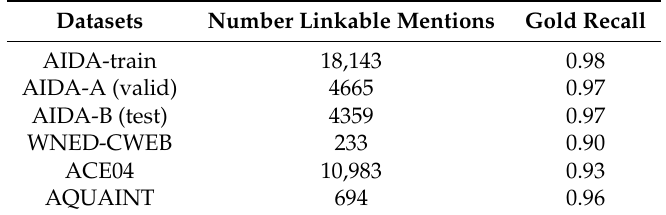
Table 2. Statistics for candidate generation. Gold recall denotes the ratio of the mentions for which the candidate entity set includes the ground truth entity.